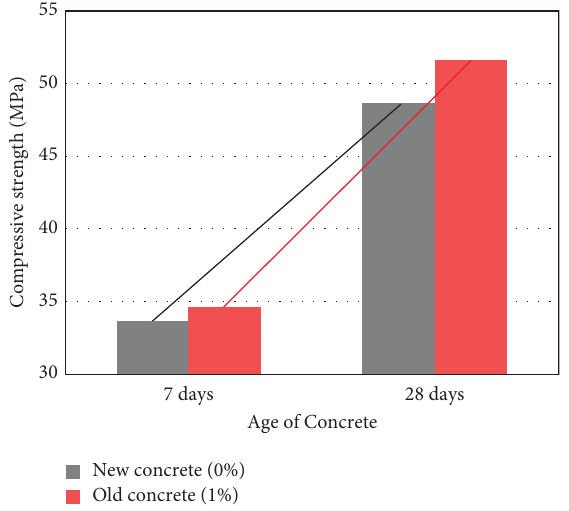
Figure 4: Test results of compressive strength. Table 2: Summary of test result on the 7 th